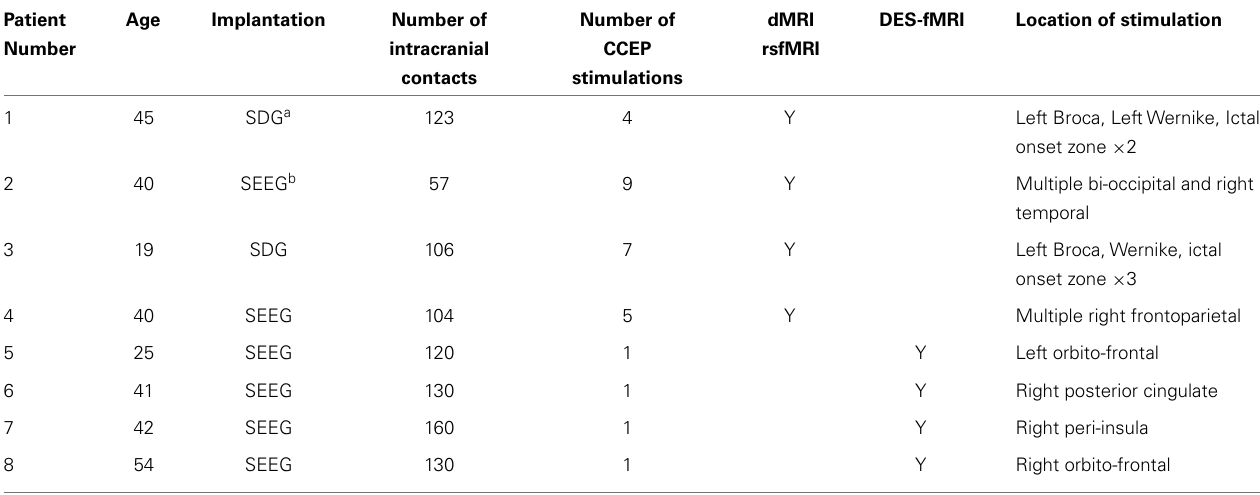
Table 1 | Details of intracranial electrodes placed in eight patients.